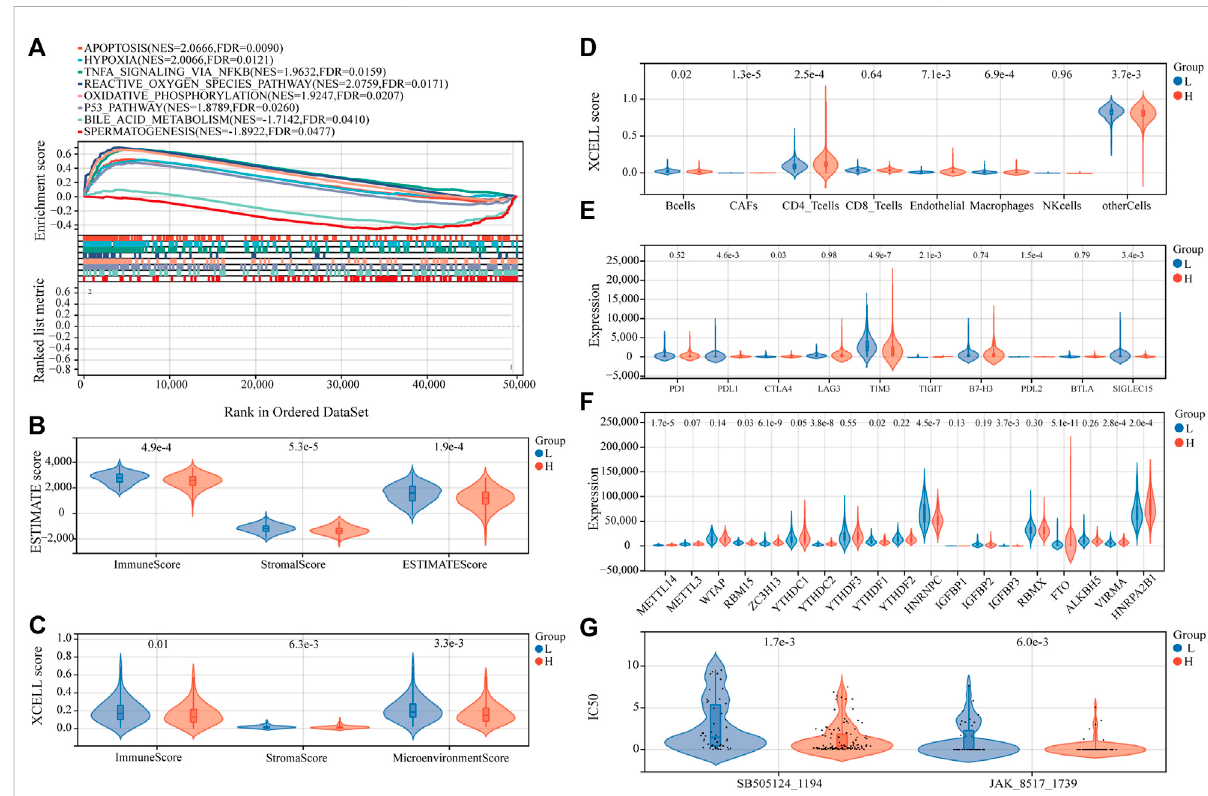
FIGURE 8 Estimationoffunctionalandimmunestatusesinthehigh-andlow-riskgroupusingexpressiondataintheTARGET-combinedcohort. (A) Gene set enrichment analysis for ferroptosis-associated signatures. Violin plots of tumor purity for the low- and high-risk groups according to the (B) ESTIMATEand (C) xCelltool. (D) Violinplotsofimmunecellabundanceinthehigh-riskandlow-riskgroupsofP-AMLpatientsusingtheEPICtool. (E) Violin plots of the expression of immune checkpoints between the high- and low-risk groups. (F) Violin plots of the expression of m6A- associatedgenesinthehigh-andlow-riskgroups. (G) ViolinplotsofthepredictedIC 50 toSB505124_1194andJAK_8517_1739inthehigh-andlow- risk